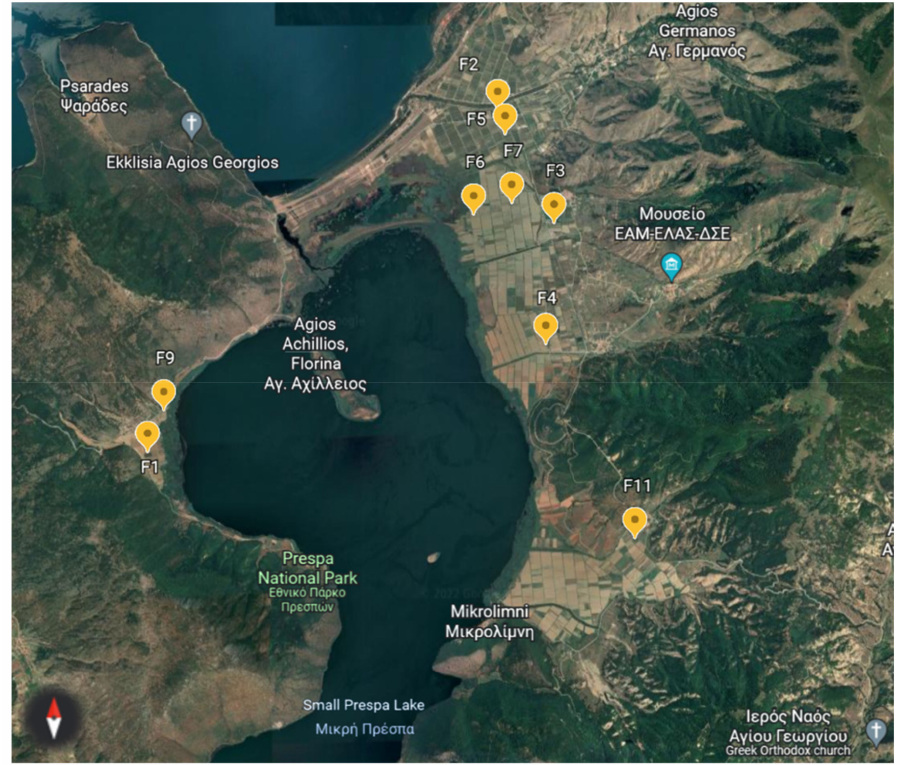
Figure 1. This is a figure. Schemes follow the same formatting. Google Earth, 2022. Mikri Prespa Lake: The nine different field sites (F1–F11) organised in 5 groups surrounding the Mikri Prespa Lake area indicated with orange placemarks,